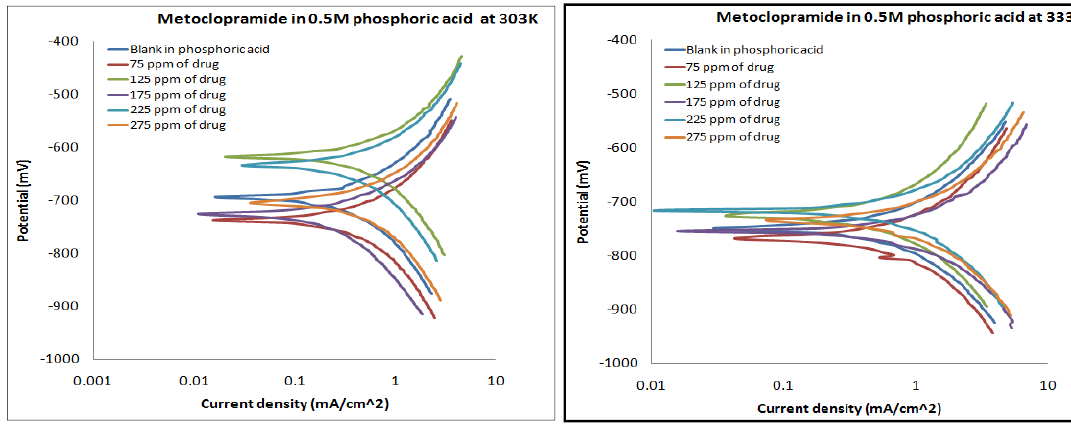
Fig. 3. Tafel plots in phosphoric acid at 303 and 33 K.